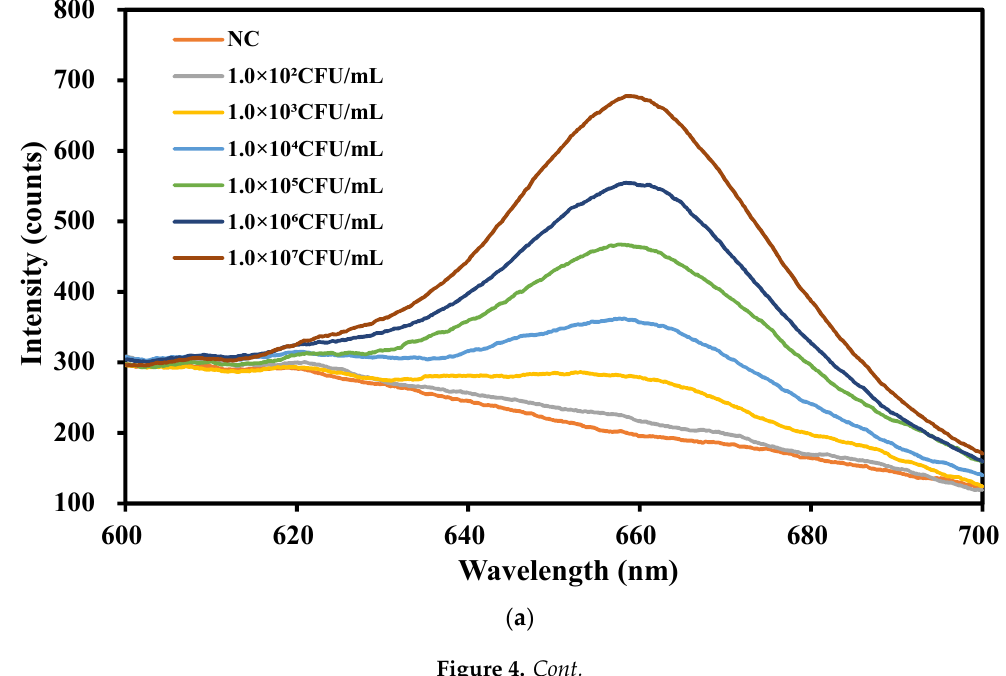
Figure 3. ( a ) The distribution of the magnetic field; ( b ) The strength of the magnetic field in the separation chamber at the vertical direction; ( c ) The strength of the magnetic field in the separation chamber at the horizontal direction; ( d ) The strength of the magnetic field from the separation chamber to the incubation